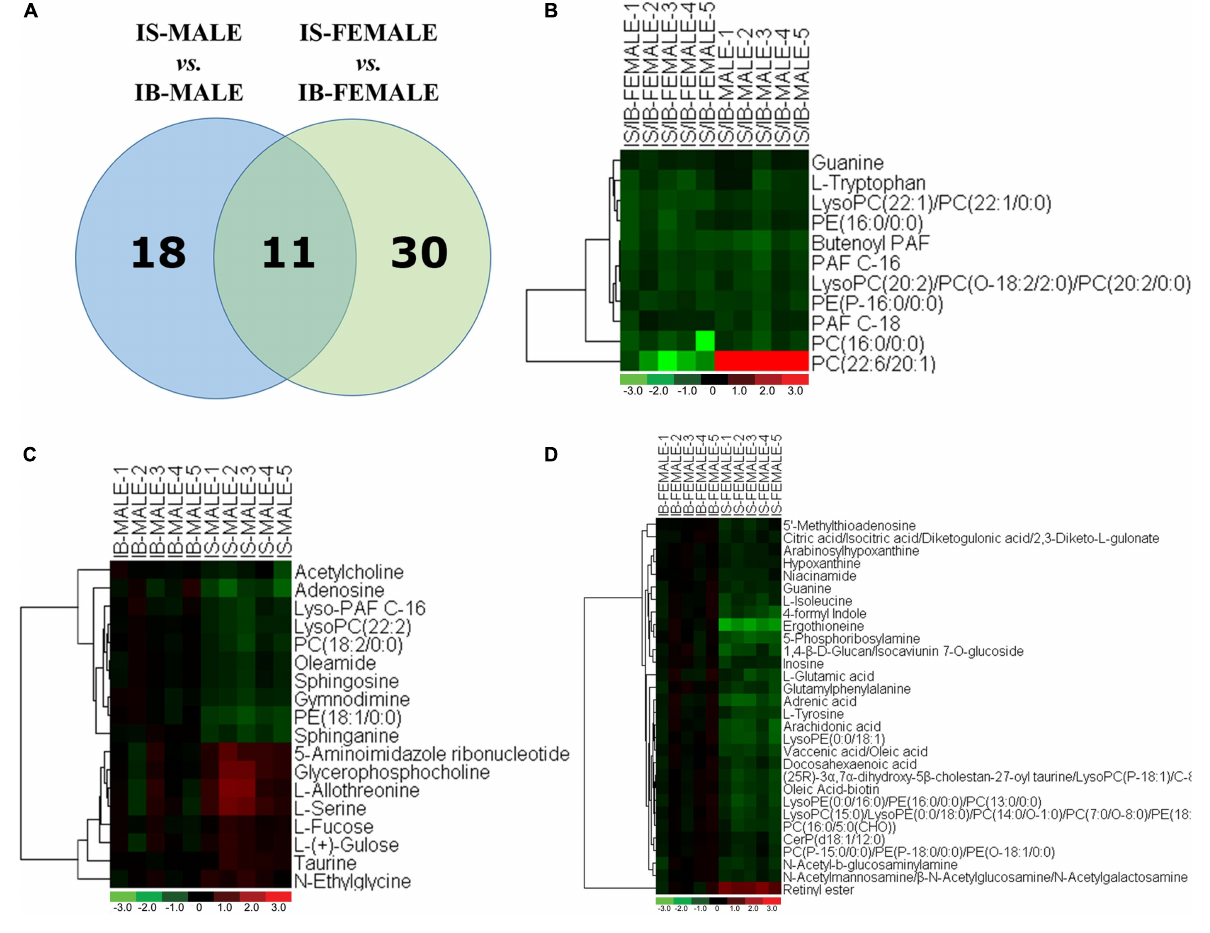
FIGURE 4 | Comparison of metabolomics between the S. japonicum worms from SCID mice and those from BALB/c mice with S. japonicum infection for 35 days heatmaps of their differential metabolites. (A) : Differential metabolites across comparison groups showing unique and common metabolites between IS-MALE vs. IB-MALE and IS-FEMALE vs. IB-FEMALE. Venn diagram displays comparatively the differentially expressed metabolites. All the differentially expressed metabolites are clustered into two comparison groups represented by two circles. The sum of all the figures in one circle represents the number of differentially expressed metabolites in one comparison group (e.g., IS-MALE vs. IB-MALE). The overlapping part of the two circles represents the number of differentially expressed metabolites shared between the two comparison groups. The single-layer part represents the number of metabolites distinctly found in a certain comparison group. (B–D) : Heatmap of the common (B) and distinct [ (C) is for male worms and (D) is for female worms] differential metabolites between male worms and female worms. For the heatmaps, normalized signal intensities (log2 transformed and row adjustment) are visualized as a color spectrum and the scale from least abundant to highest ranges is from –3.0 to 3.0 as shown in the colorbar. Green indicates decreased expression, whereas red indicates increased expression of the detected metabolites between compared groups. The sample size is 5 in each group of worm